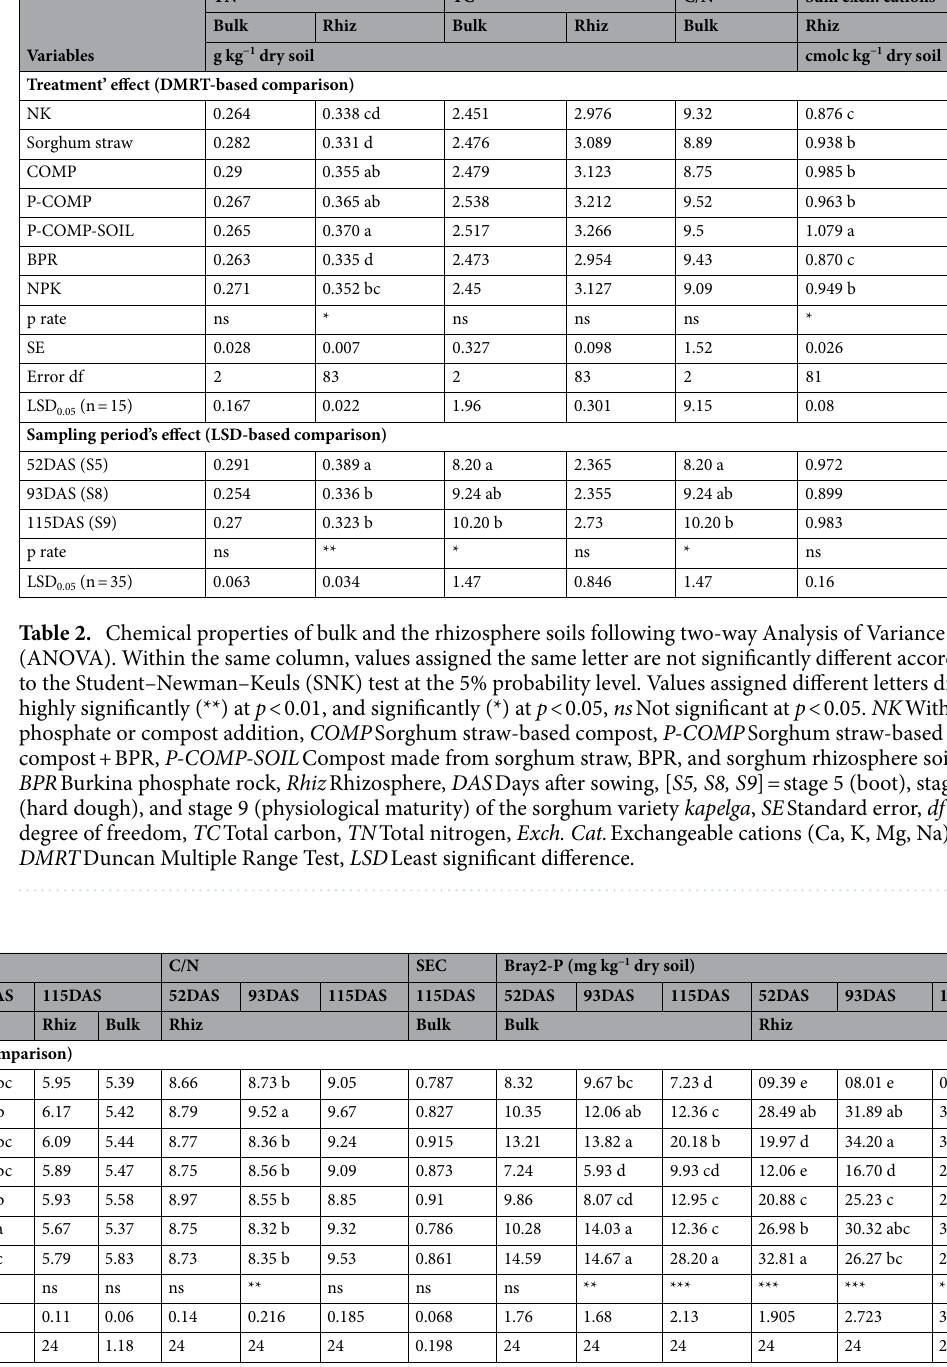
Table 3. Chemical parameters of bulk and rhizosphere soils over sampling periods following one-way Analysis of Variance (ANOVA). Within the same column, values assigned the same letter are not significantly different according to the Student–Newman–Keuls (SNK) test at the 5% probability level. Values assigned different letters differ highly significantly (***) at p < 0.001, (**) at p < 0.01, and significantly (*) at p < 0.05, ns Not significant at p < 0.05. NK Without phosphate or compost addition, COMP Sorghum straw-based compost, P-COMP Sorghum straw-based compost + BPR, P-COMP-SOIL Compost made from sorghum straw, BPR, and sorghum rhizosphere soil, BPR Burkina phosphate rock, Rhiz Rhizosphere, DAS Days after sowing, SE Standard error, Error df Error degree of freedom, SEC Sum of exchangeable cations (Ca, K, Mg, Na) with the unit cmolc kg −1 dry soil, DMRT Duncan multiple range